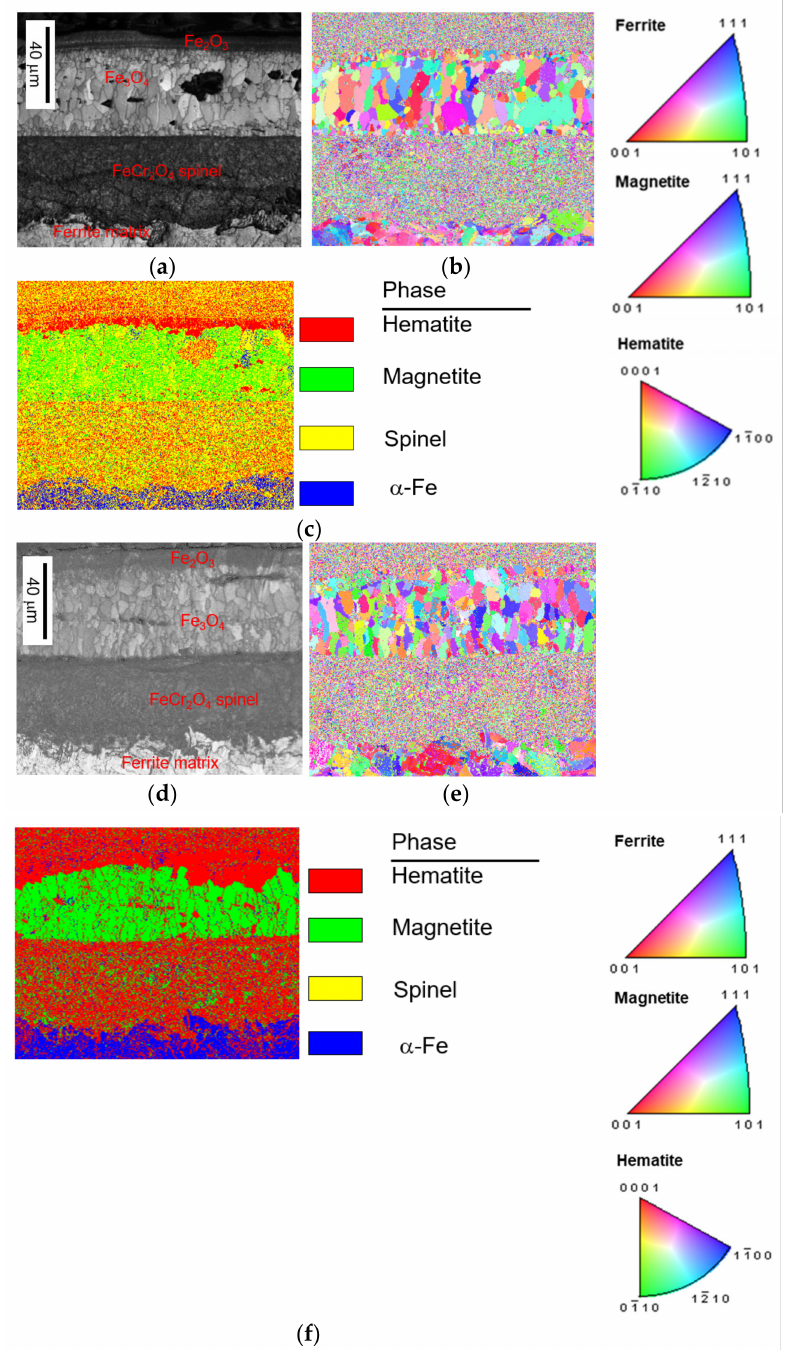
Figure 4. EBSD results of the oxidation scale of T91 test: ( a ) IQ map, ( b ) IPF with orientation map, ( c ) phase map of untreated specimens after 200 h steam exposure, ( d ) IQ map, ( e ) IPF with orientation map, and ( f ) phase map of SP-treated specimens after 200 h steam